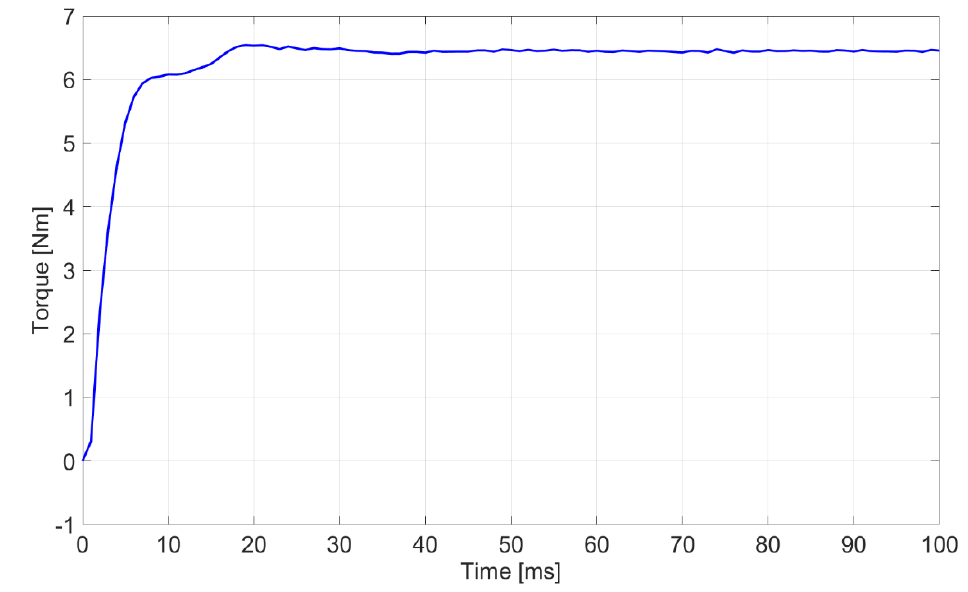
Figure 12. Torque vs time in a transient finite element analysis. Table 5. Comparison between the methods.